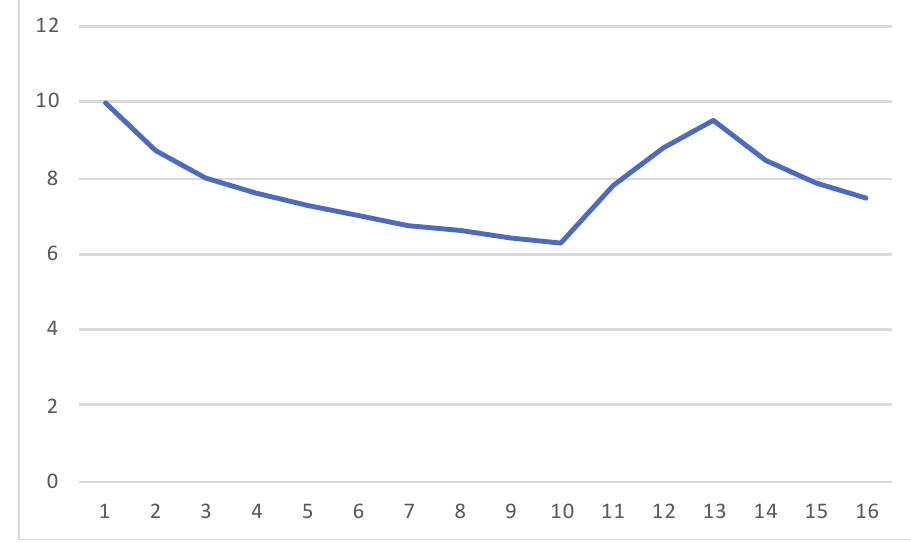
Fig. 1 . Example of the learning/forgetting